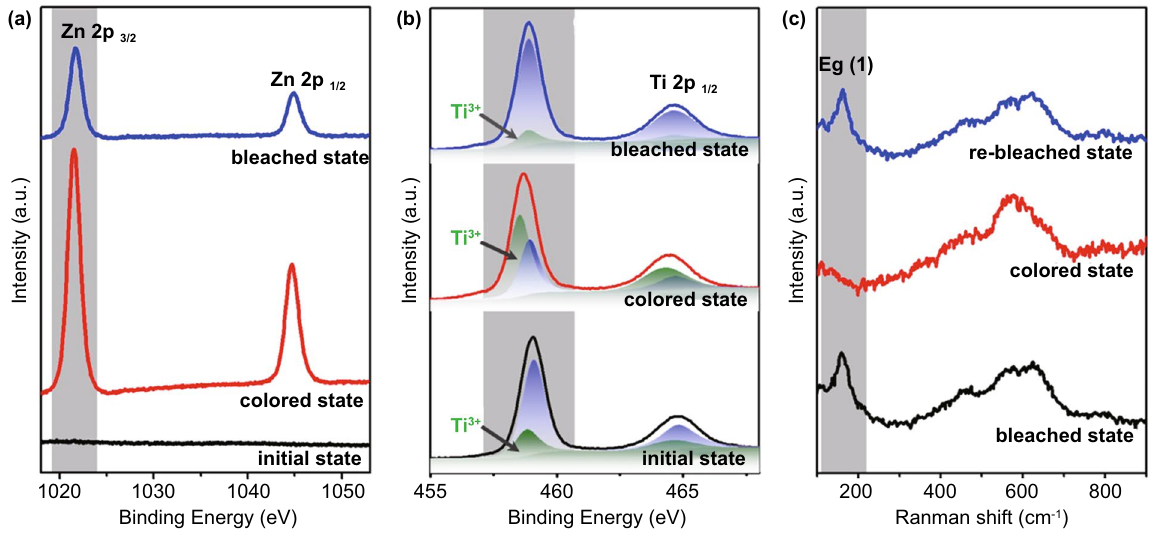
Fig. 3 Structural evolution of a W-doped TiO 2 NC film during the Zn 2+ electrochromic process. a–b Ex situ high-resolution XPS spectrum of Zn 2p ( a ) and Ti 2p ( b ) in the initial, colored (0 V) and bleached (1.3 V) states. c In situ Raman spectra during the colored and bleached